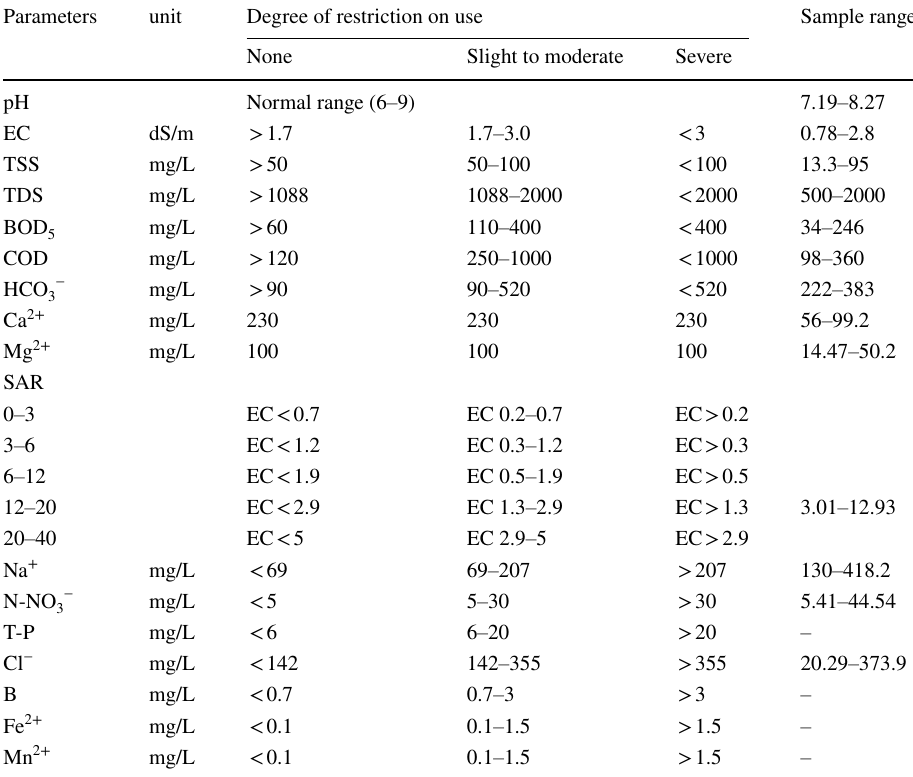
Table 5 water – irrigation water quality guideline (JS 1766,